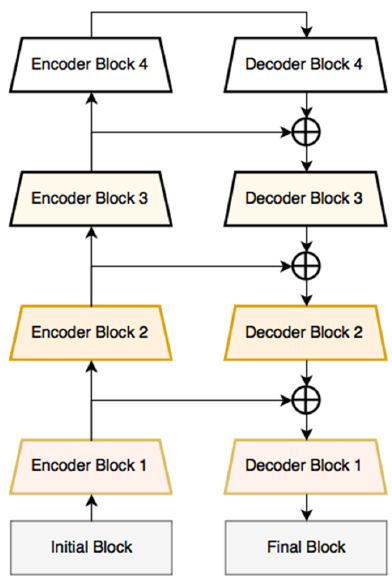
Figure 4. DNN LinkNet architecture scheme